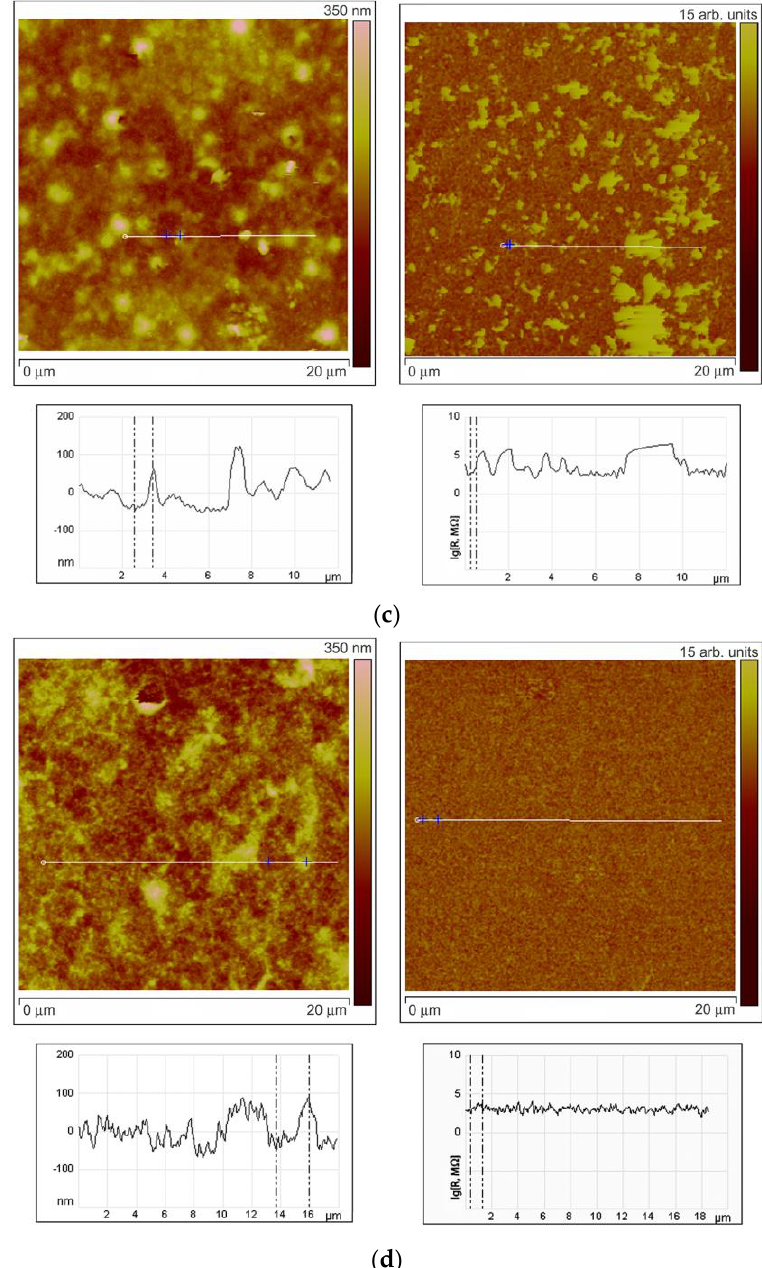
Figure 6. Results of SSRM experiment. Surface topography with cross-sections (on the left side) and the surface distribution of the local resistance with cross-sections (on the right side) for the ZnO(Ga,In) samples containing 1.0–1.3 at.% Ga and ( a ) 0 at.%, ( b ) 0.74 at.%, ( c ) 3.4 at.%, and ( d ) 5.9 at.% In.